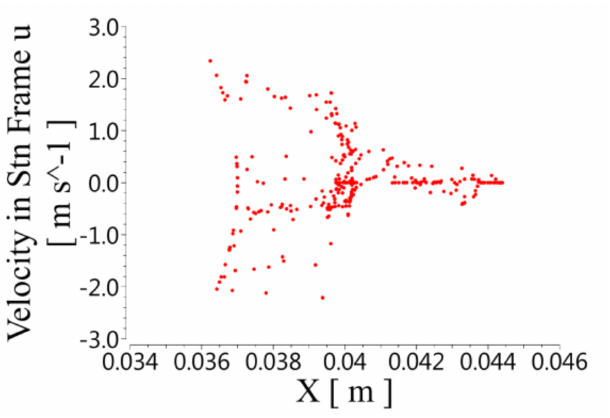
Figure 8. Distribution of radial velocity at different X positions on the XY plane.